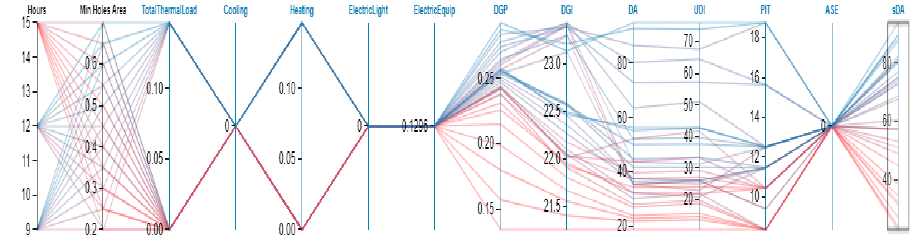
Figure 20. Comparative analysis of the performance of 33 options for fixed shading devices on June 21st ( top ) and December 21st ( down ).